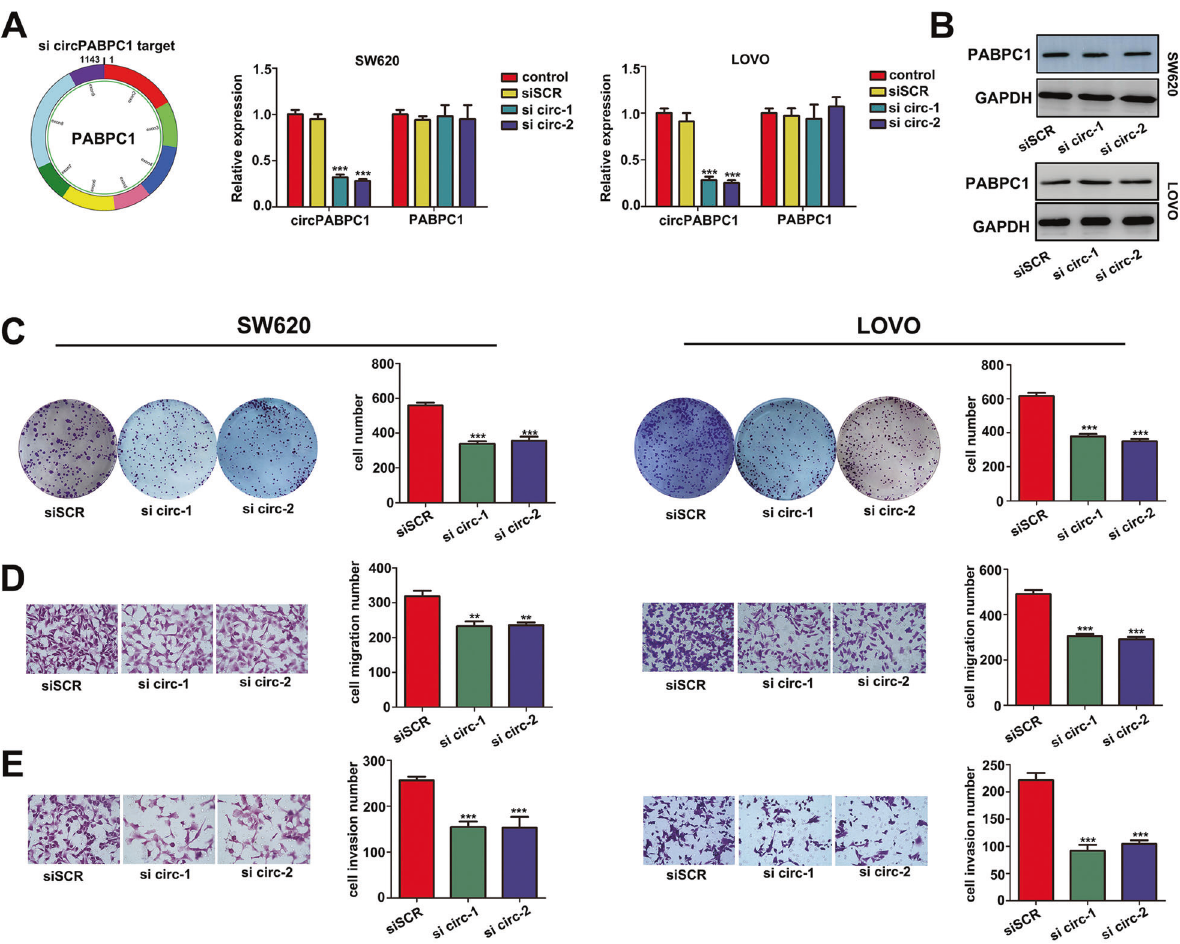
Fig. 2 Knockdown of cirPABPC1 suppresses CRC cell proliferation and invasion in vitro. A CircPABPC1-speci fi c siRNA signi fi cantly decreased circPABPC1 expression but had no effect on PABPC1 mRNA expression. B The protein level of PABPC1 was detected by western blot after si circPABPC1 transfection. C – E Colony formation, cell migration and invasion assays were used to detect the effect of circPABPC1 on cell proliferation and invasion. Quantitative data from three independent experiments are shown as the mean ± SD (error bars). * P <